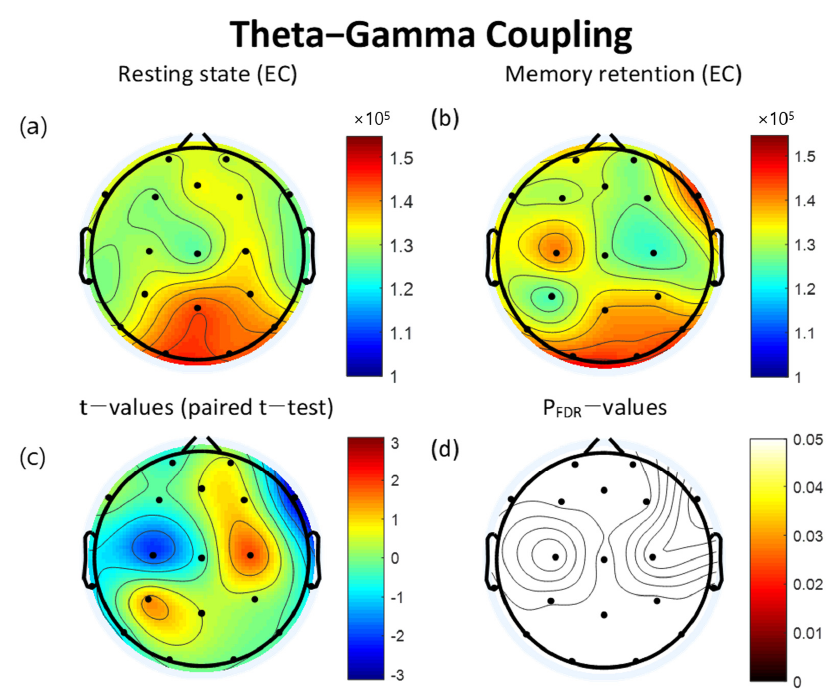
Figure 4. Topographies of theta-gamma coupling (TGC) during eyes-closed resting state and the retention interval of the visual working memory (VWM) task, t -map, and p FDR -map. The topographic maps represent the probability of paired t -test between resting state and VWM task. ( a ) Modulation index (MI) of TGC during the resting state. ( b ) MI of TGC during the retention interval of VWM task ( c ) Topographical distribution of t -values (paired t -test). ( d ) Topographical distribution of the corresponding False Discovery Rate corrected p -value (paired t -test). EC: eyes closed, FDR: False Discovery Rate. Table 5. Pearson’s correlation coefficients between the absolute gamma power and WURS in healthy volunteers.